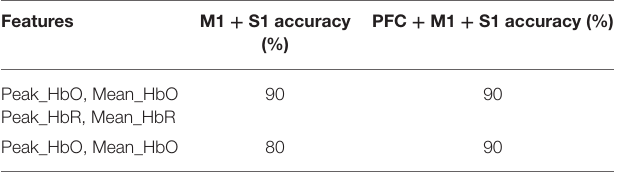
TABLE 2 | Classification accuracies of the fNIRS-based motor imagery task for the healthy control subjects. Features